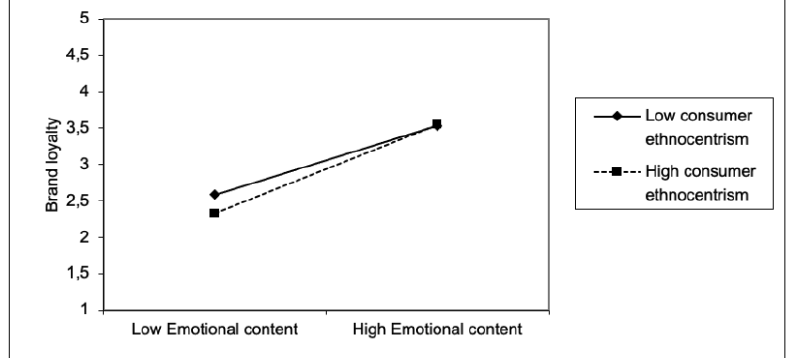
Figure 8 : The moderating effect of consumer ethnocentrism on the relation between cultural content and brand loyalty